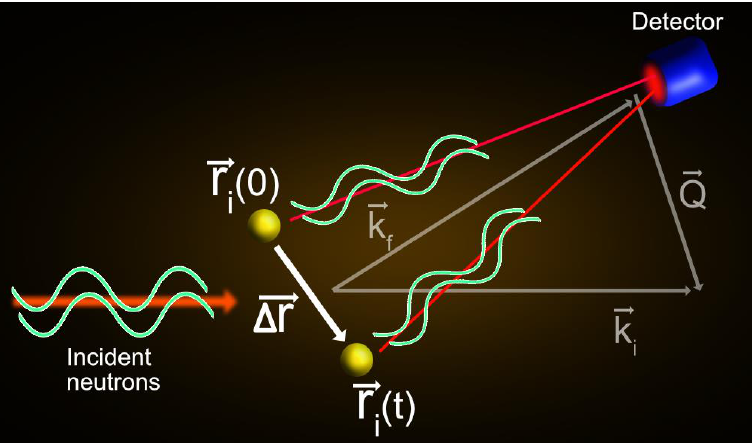
→ → r i ( 0 ) and r i ( t ) . The scattered waves